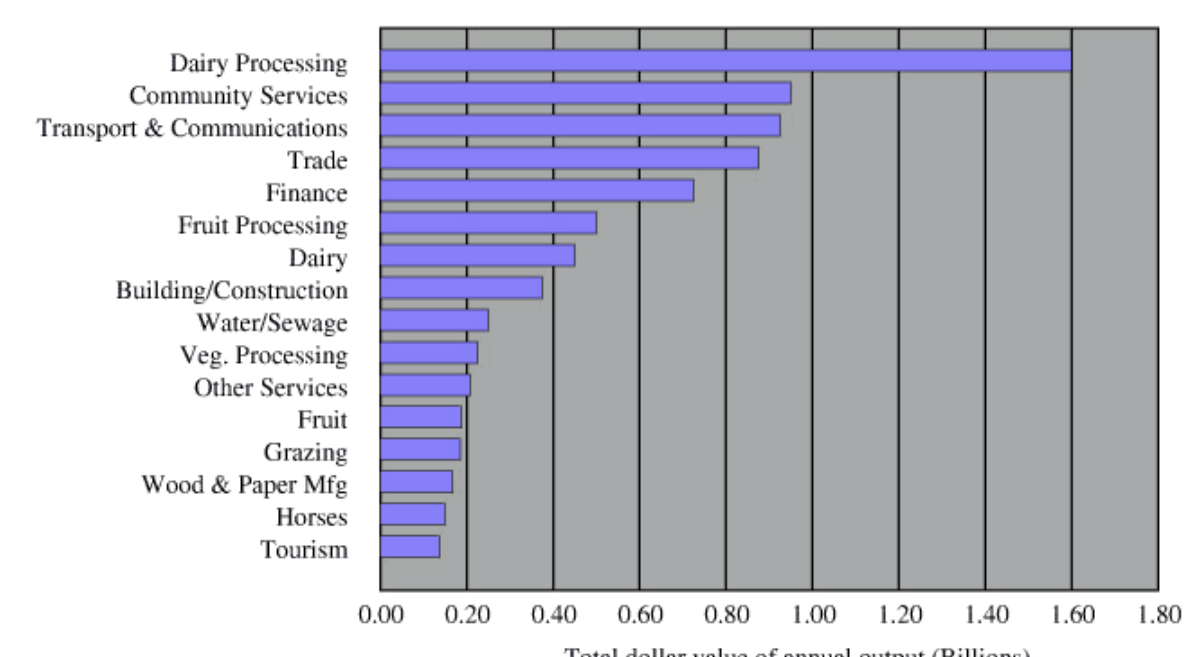
Fig. 3. Contributions of the 10 largest sectors to total dollar value of output (Source: model built by Plant et al.